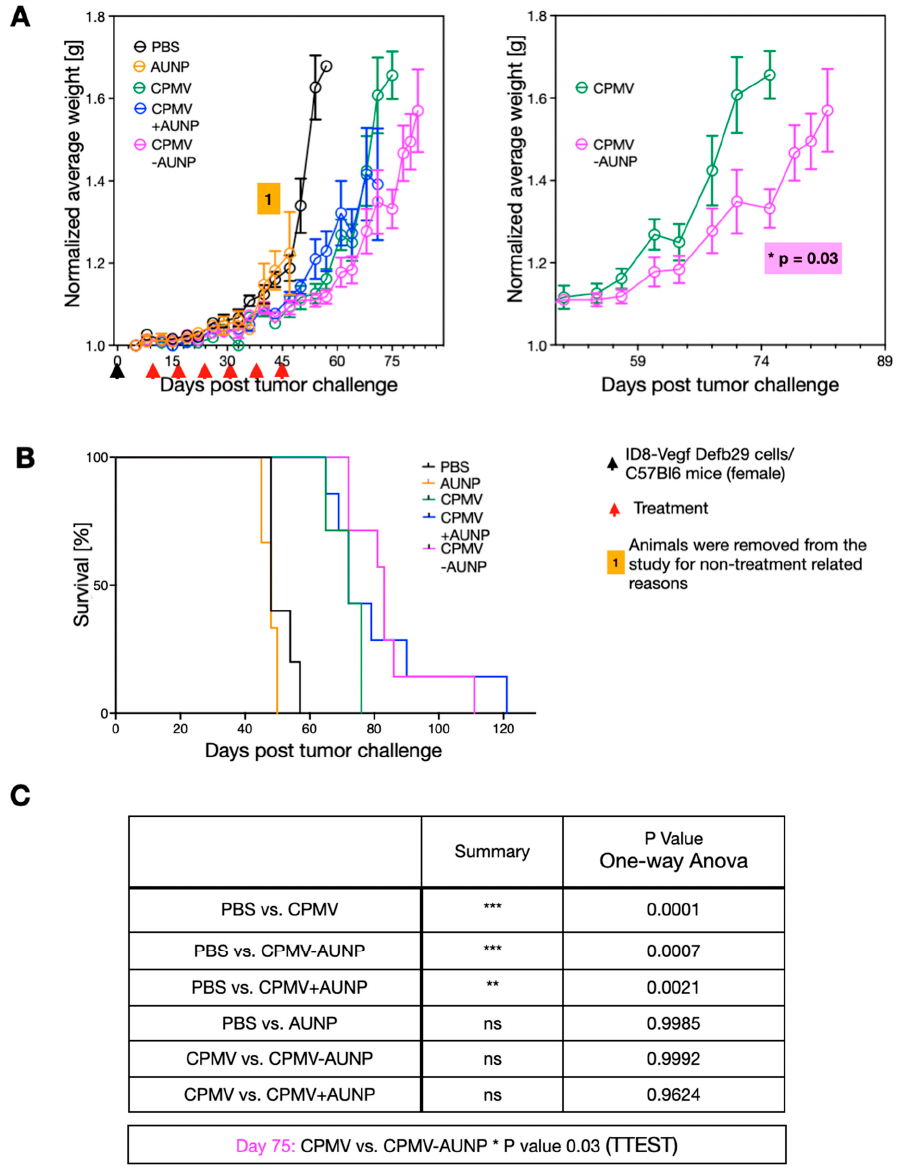
Figure 3. CPMV-AUNP as cancer immunotherapy against ovarian cancer. ( A ) Female C57BL/6 mice were inoculated (i.p.) with 2 × 10 6 ID8-Defb29/Vegf-A cells, followed by six weekly injections (i.p.) of PBS control ( n = 5), 1 µg AUNP ( n = 3), 100 µg CPMV ( n = 5), 100 µg CPMV-AUNP ( n = 7), and 100 µg CPMV+ 1 µg AUNP physical mixture ( n = 7). Body weight was measured to monitor tumor growth. Right panel excerpt of complete data set from the left panel. Data are means ± SEM. Data are plotted for a minimum of n = 3 per group. ( B ) Survival curves of the treatment groups. ( C ) Statistics of data presented in panel A; statistical significance was calculated by one-way ANOVA and t test. *** p < 0.001, ** p < 0.005, ns: not significant.